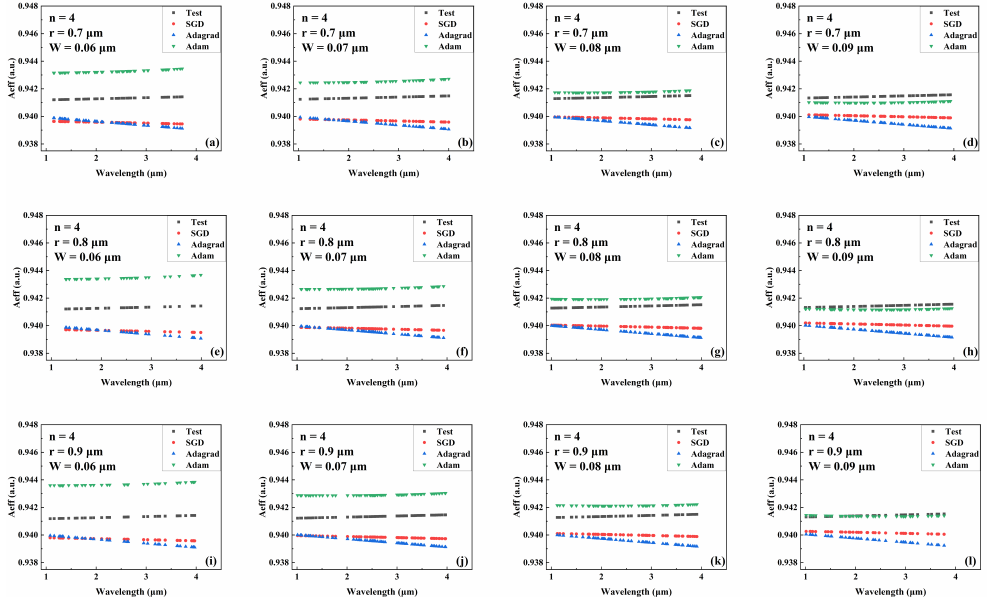
Figure 5. Comparison of the predicted and actual values of A ef f in the test data set of the network model trained by different optimizers for different combinations of core radius and cantilever width (number of cantilevers: 4). ( a ) r = 0.7 µ m, W = 0.06 µ m. ( b ) r = 0.7 µ m, W = 0.07 µ m. ( c ) r = 0.7 µ m, W = 0.08 µ m. ( d ) r = 0.7 µ m, W = 0.09 µ m. ( e ) r = 0.8 µ m, W = 0.06 µ m. ( f ) r = 0.8 µ m, W = 0.07 µ m. ( g ) r = 0.8 µ m, W = 0.08 µ m. ( h ) r = 0.8 µ m, W = 0.09 µ m. ( i ) r = 0.9 µ m, W = 0.06 µ m. ( j ) r = 0.9 µ m, W = 0.07 µ m. ( k ) r = 0.9 µ m, W = 0.08 µ m. ( l ) r = 0.9 µ m, W = 0.09 µ